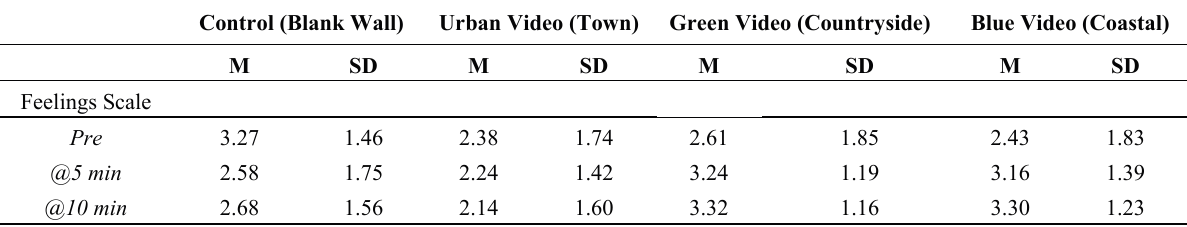
Table 2. Means (M) and standard deviations (SD) for psychological variables at all times points in all four